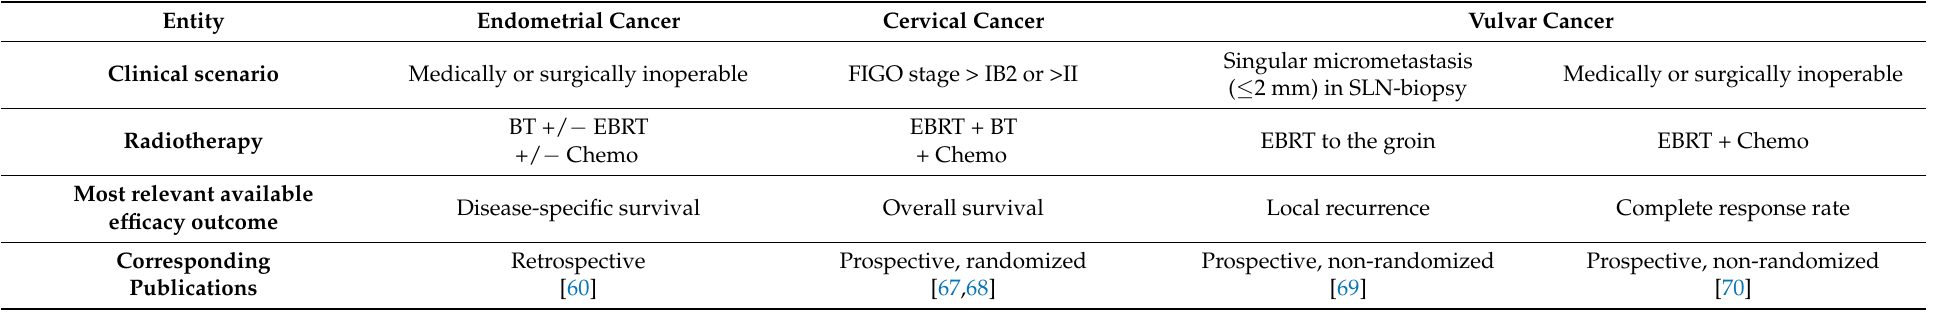
Table 2. Schematic overview of common indications for primary radiotherapy in newly diagnosed localized gynecological malignancies. Primary radiotherapy is generally not used for ovarian cancer. The approach towards vaginal cancer is similar to that for cervical cancer. Ovarian and vaginal cancer are therefore not listed